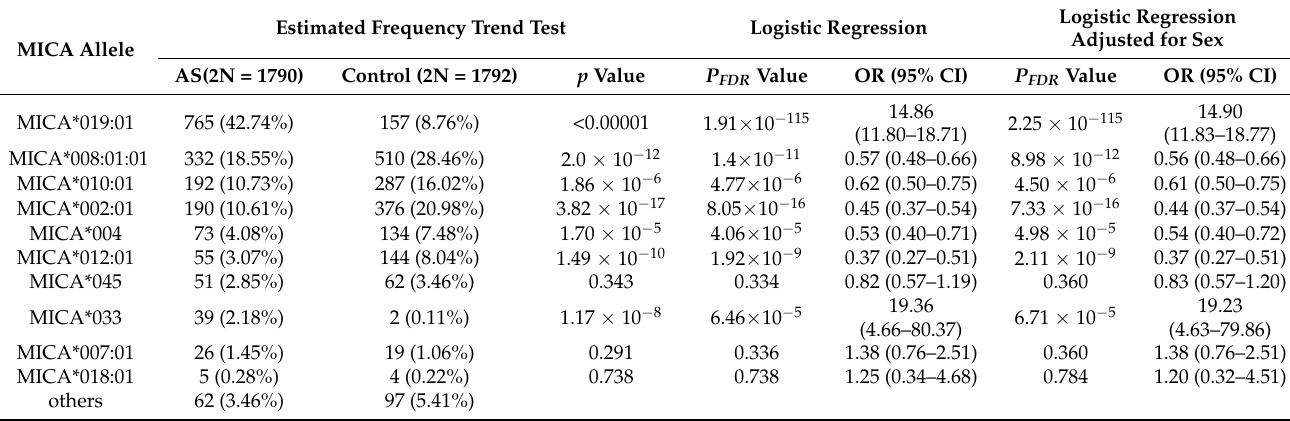
Table 1. Comparison of MICA allele frequencies between Taiwanese normal healthy controls and AS patients.